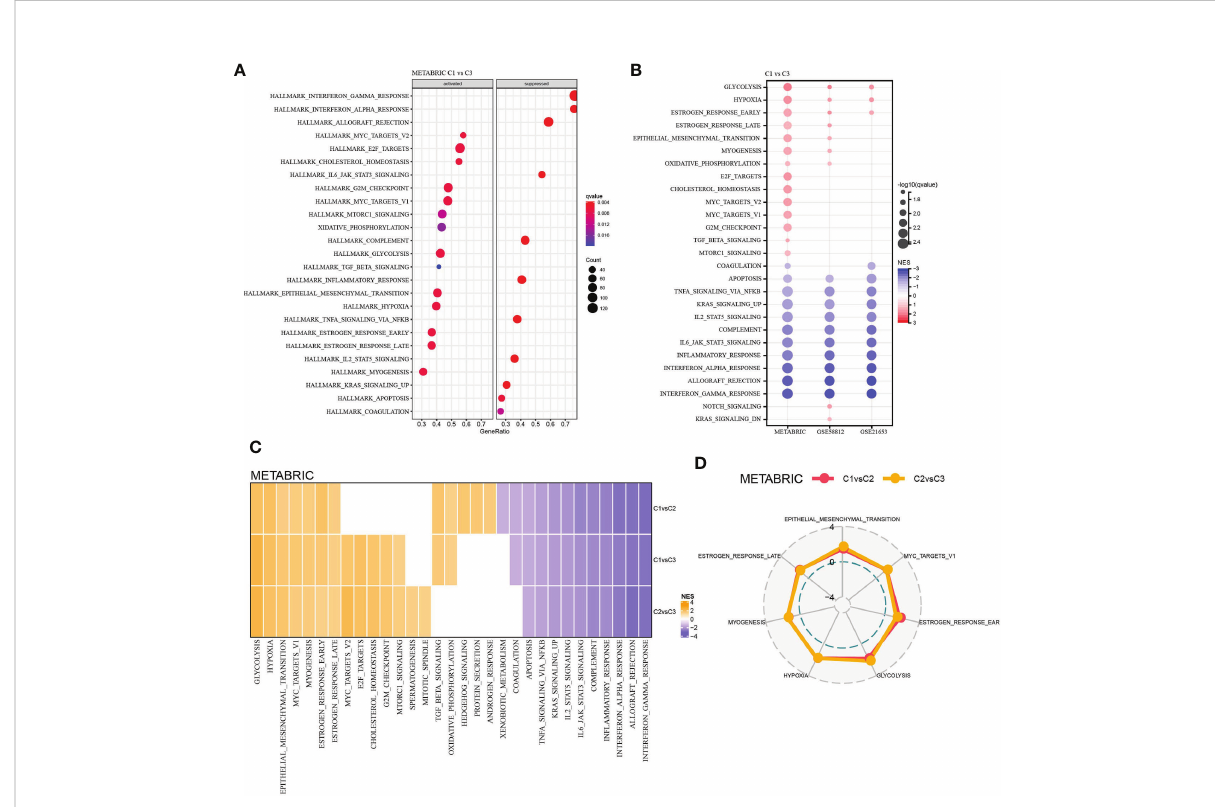
FIGURE 4 Functional analysis among the LR pairs-based molecular subtypes. (A) Bubble chart showing results of the GSEA comparing the C1 with the C3 subtype in METABRIC cohort. (B) Bubble chart showing results of the GSEA comparing the C1 with the C3 subtype in the three cohorts. (C) Heatmap of the normalized enrichment scores (NES) of the GSEA comparing C1 versus C2, C1 versus C3, and C2 versus C3, and the vertical axis represents the different comparison, while the honrizontal axis represents names of the pathways. (D) Radar plot showing pathways coherently activated in C1 versus C2 and C2 versus C3 in the METABRIC